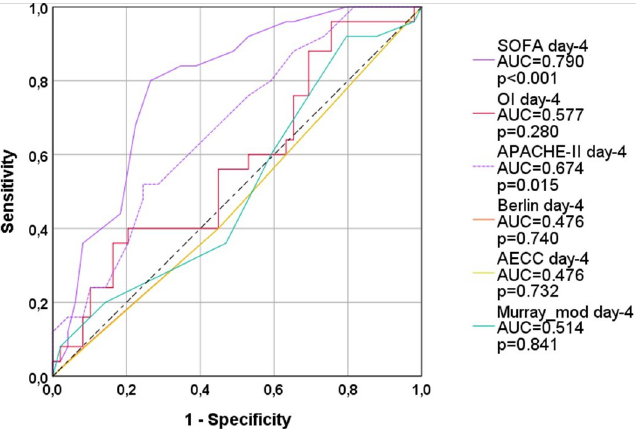
Fig 4. ROC-AUC regarding 28d-mortality (all patients; day 4). OI: oxygenation index; AECC: American European Consensus Conference; Murray_mod: modified Murray-score (sum of points without radiological points); AUC: area under the curve. APACHE-II: Acute Physiology And Chronic Health Evaluation; SOFA: Sequential Organ Failure Assessment.